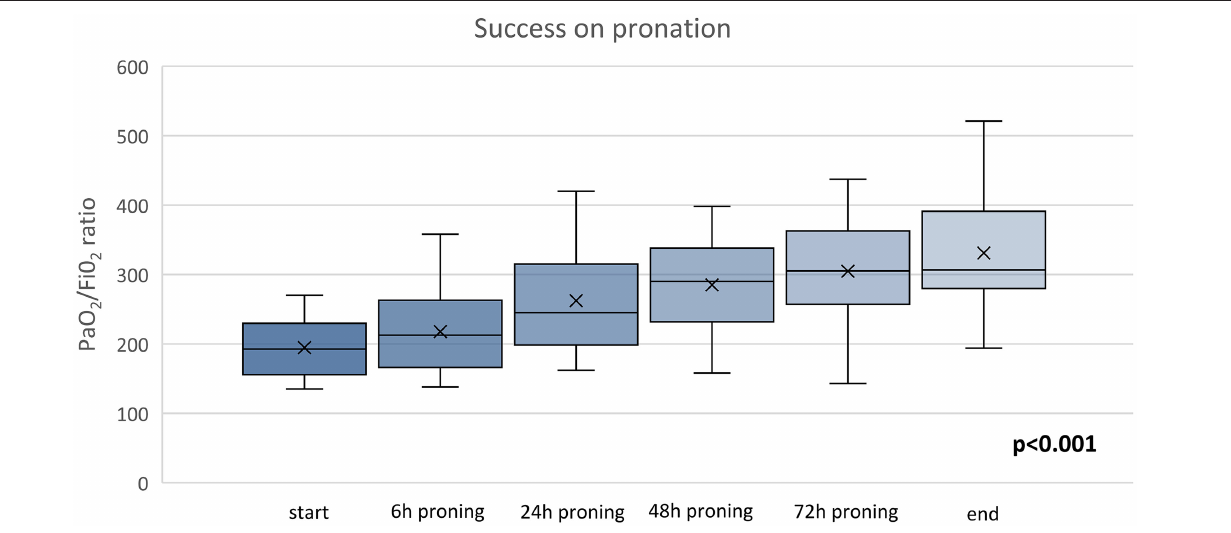
FIGURE 3 | Time course of PaO 2 /FiO 2 of PP group ANOVA, p = 0.001. The x refers to the average value and the continuous line refers to the median value.